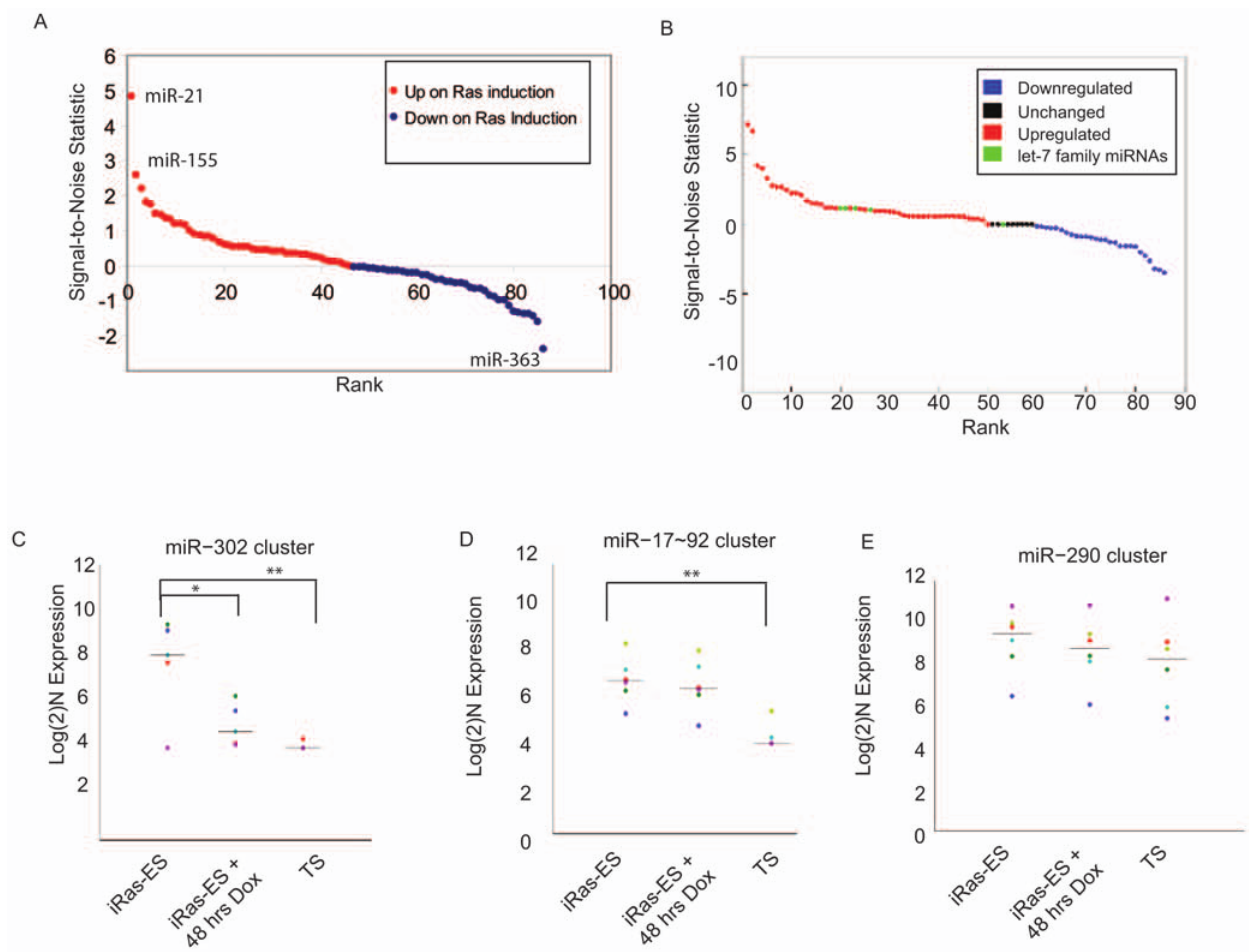
Figure 3. Identification of pluripotency-associated and differentiation-associated miRNAs. Comparative marker selection score plot for miRNAs differentially expressed between 0 and 44 hrs of HRas/Q61L induction (a) and for miRNAs showing expression difference between undifferentiated TS-cells and TS-cells induced to differentiate by withdrawal of FGF4 (b) . Signal-to-noise statistic score is plotted vs. overall rank. For c–e, the expression of miRNAs within three pluripotency-associated miRNA clusters was assessed in: uninduced iRas-ESCs (iRas-ES), iRas-ESCs induced with doxycycline for 48 hrs (iRas-ES + 48 hrs Dox), and BD-TS cells (TS). Individual family members within each cluster are demarked by different colors. c) miR-302 cluster (miRNA 302a, 302b, 302c, 302d, 367). *, p , 0.05; **, p , 0.01 by two-tailed unpaired Student’s t-test. d) miRNA 17-92 cluster